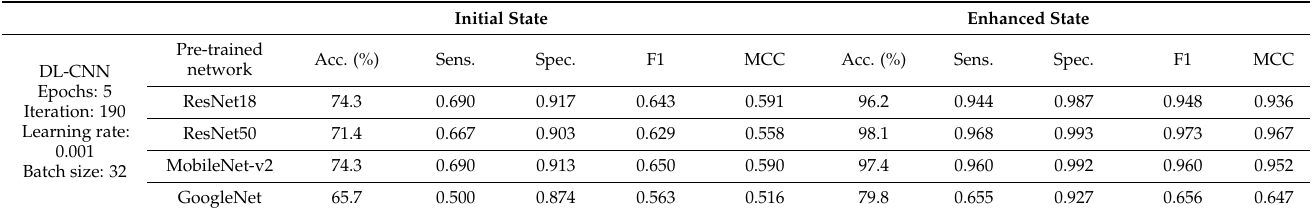
Table 13. HAR performance in local SS dataset.